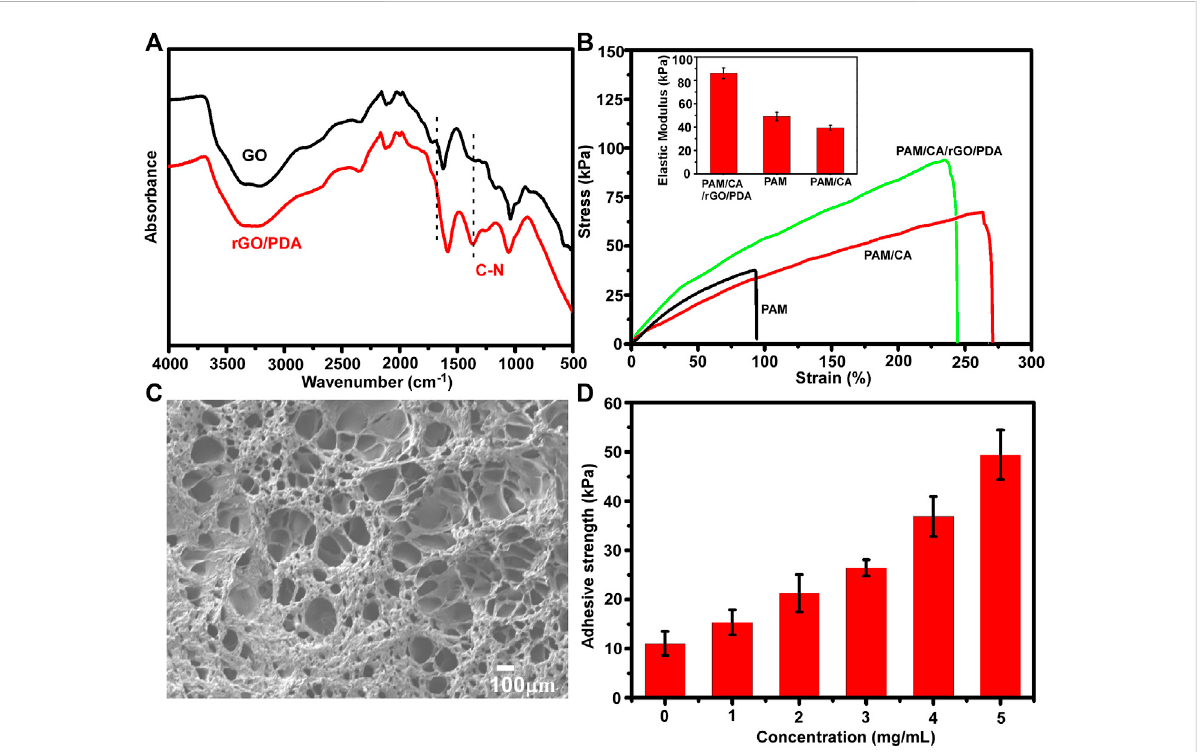
FIGURE 2 Characterization of the adhesive DN hydrogel. (A) FTIR spectra of dried GO and rGO/PDA. (B) Stress − strain curves of the DN hydrogel; insets show the elastic modulus. (C) SEM images of a dry adhesive DN hydrogel. (D) Adhesion strengths of the DN hydrogel onto porcine skin tissues with different concentrations of